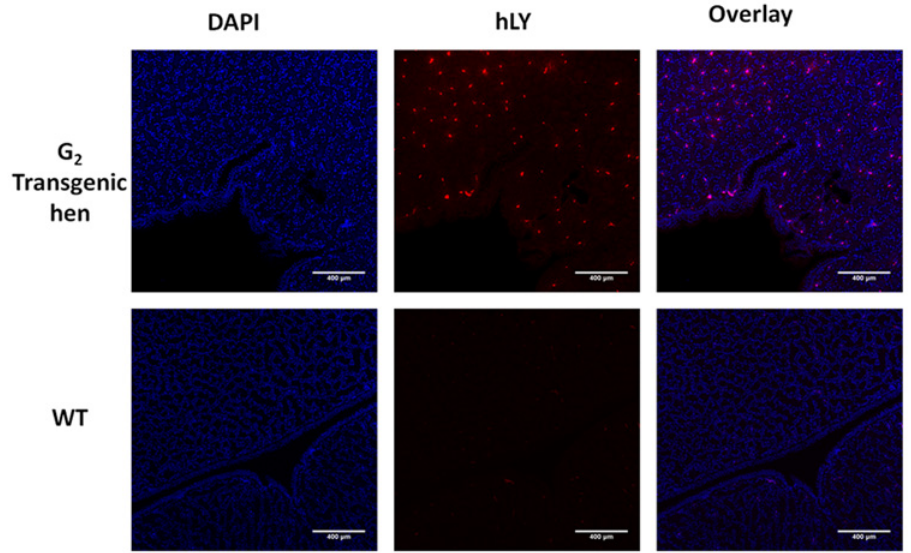
Fig 7. Immunofluorescence detection of hLY in oviduct sections. Sections of the magnum portion of the oviduct of G 2 transgenic hen which was the offspring of G 1 transgenic rooster A011 and a wild type White Leghorn were immunolabeled with an anti-hLY antibody. The nuclei are stained with DAPI and hLY staining is in